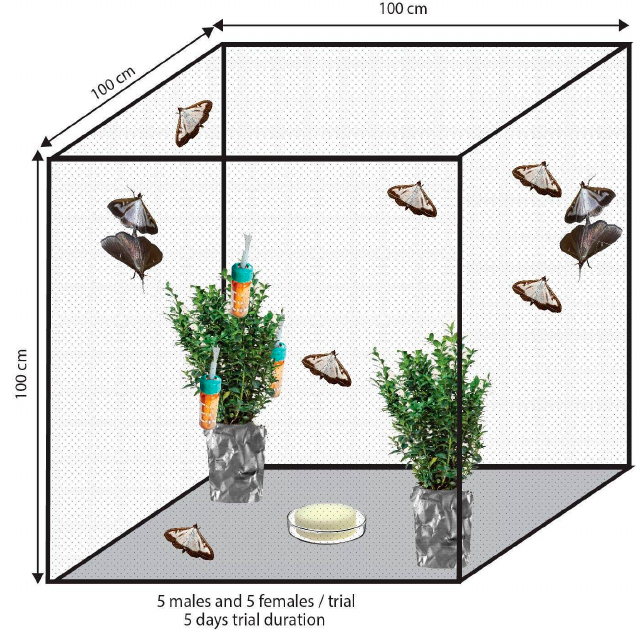
Figure 1. The scheme of the two-choice oviposition bioassay for adult box tree moths in screened cages with polyester netting. Two potted boxwood plants were offered for oviposition, one treated with essential oil-filled vial-wick dispensers compared against an untreated plant.